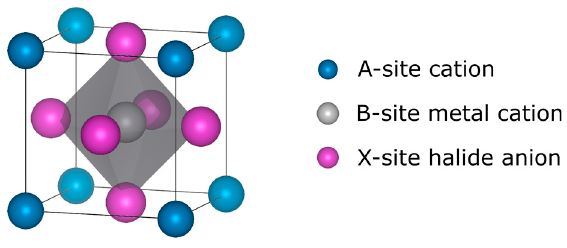
Figure 1. Cubic perovskite unit cell.